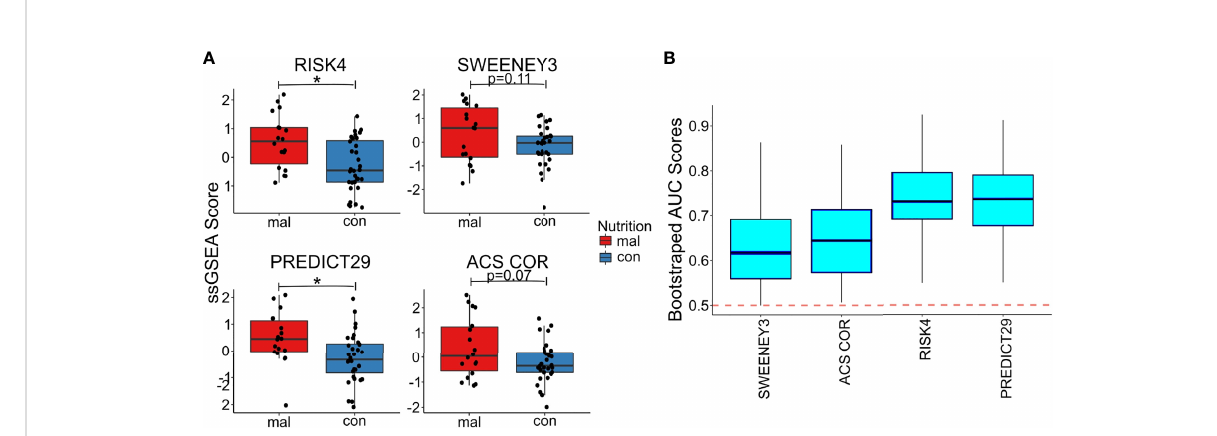
FIGURE 3 Malnourished individuals with LTBI demonstrate a higher risk of TB progression than controls with LTBI. Accuracy of TB risk signatures in predicting differences between malnourished individuals and control groups as depicted by boxplots showing ssGSEA scores [RISK4, p=0.0003; PREDICT29, p = 0.0038; ACS COR, p = 0.076; and SWEENEY3, p = 0.10; (A) ] and bootstrapped upper and lower AUC scores and means [RISK4, AUC = 0.73; PREDICT29, AUC = 0.74; ACS COR, AUC = 0.63; and SWEENEY3, AUC = 0.61; (B) ]. * signi fi cant p